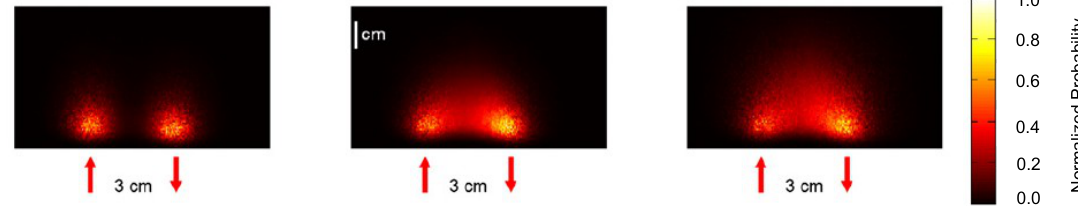
= 0.01 mm −1 , and μ ′ = 0.5 mm −1 a s